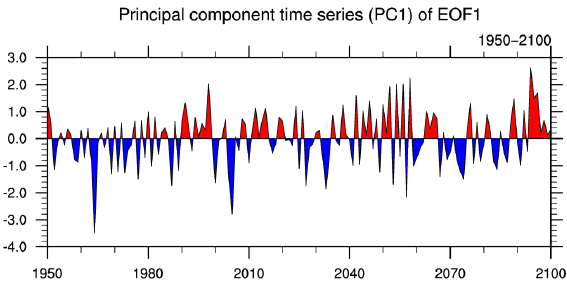
Figure 2. Normalized principal component time series (PC1) of the leading empirical orthogonal function (EOF1) of the winter mean sea-level pressure (SLP) anomalies for the entire simulation period (1950–2100). The PC1 has been computed after removing the SLP climatology for the recent past (1980–2010).